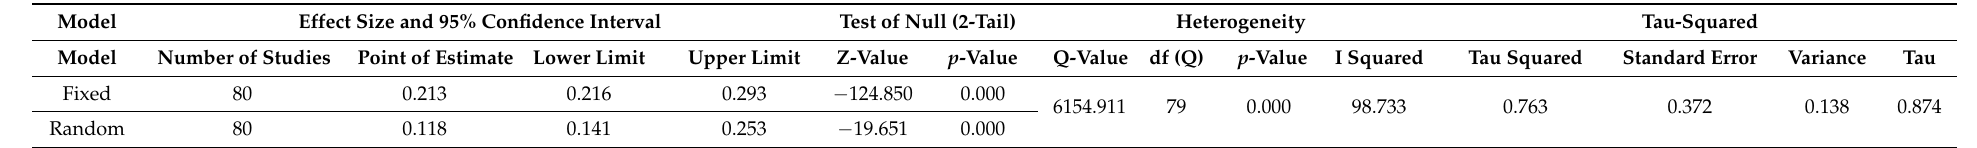
Table 2. Meta-analysis and effect analysis values of included studies, homogeneous distribution value, average effect size, and confidence